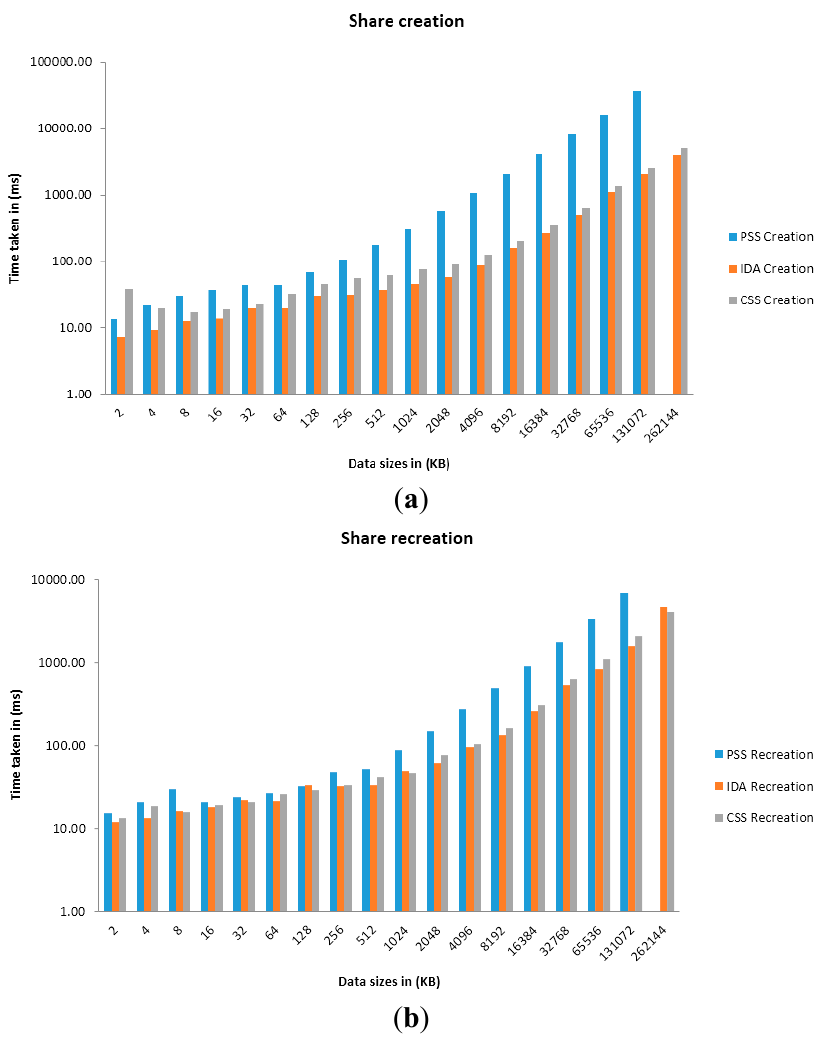
Figure 5. Graphs of Time taken against Data sizes in share creation ( a ) and recreation ( b ) when n = 10, t =